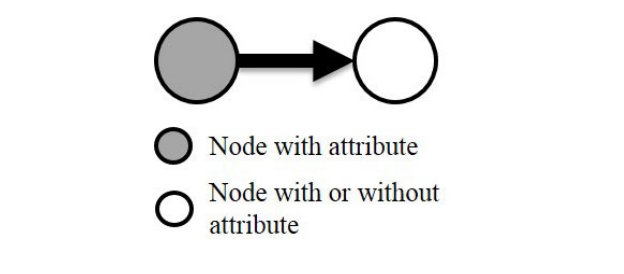
Fig. 3 . Coordination tie based on attribute.